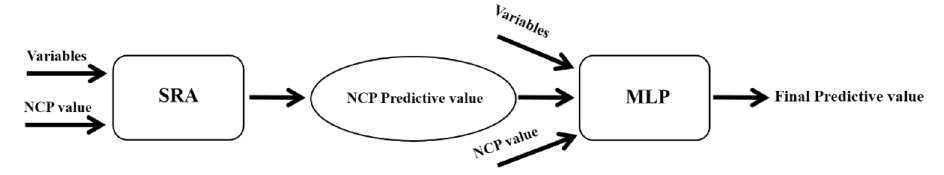
Figure 5. The flux diagram of the regression